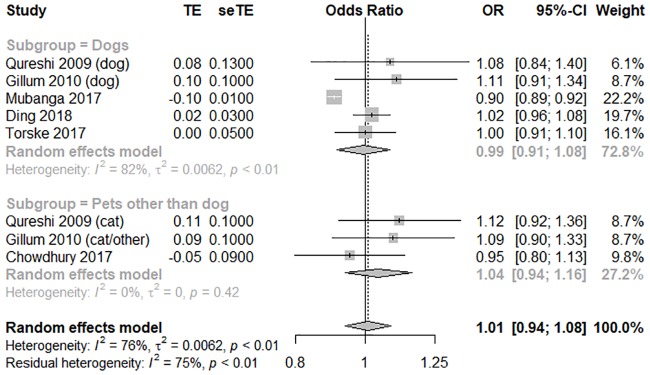
A forest plot of adjusted all-cause mortality, comparing pet owners and non-pet owners, with a subgroup analysis by pet type.CI, confidence interval; OR, odds ratio; SE, standard error; TE, treatment effect.